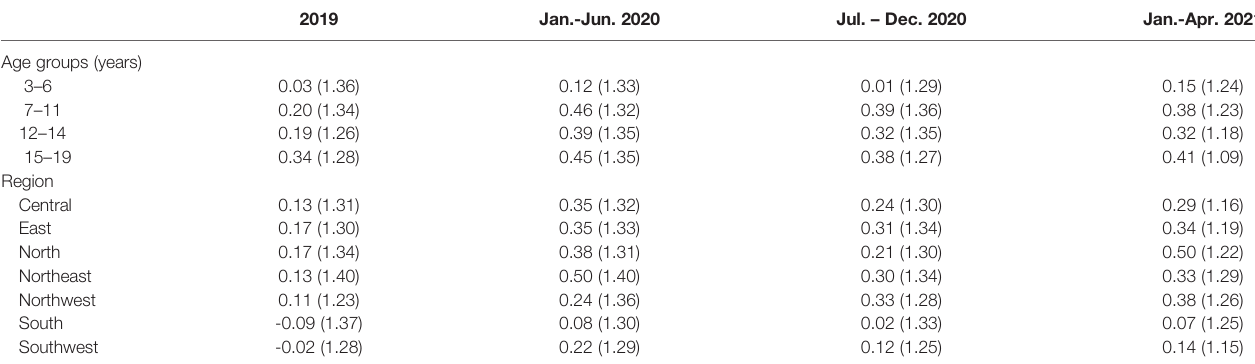
TABLE 2 | BMI z-score changes during COVID-19 shutdown by different ages and